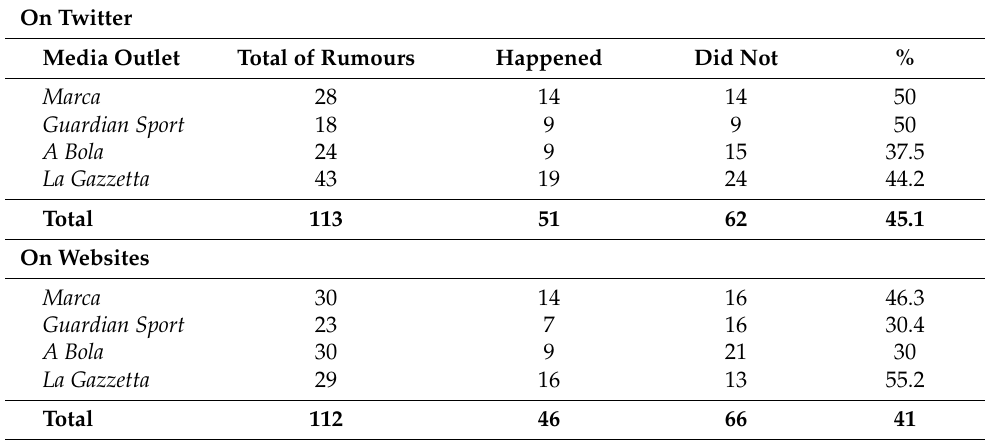
Table 3. The table shows the percentage of published rumours about football deals that finally happened. On